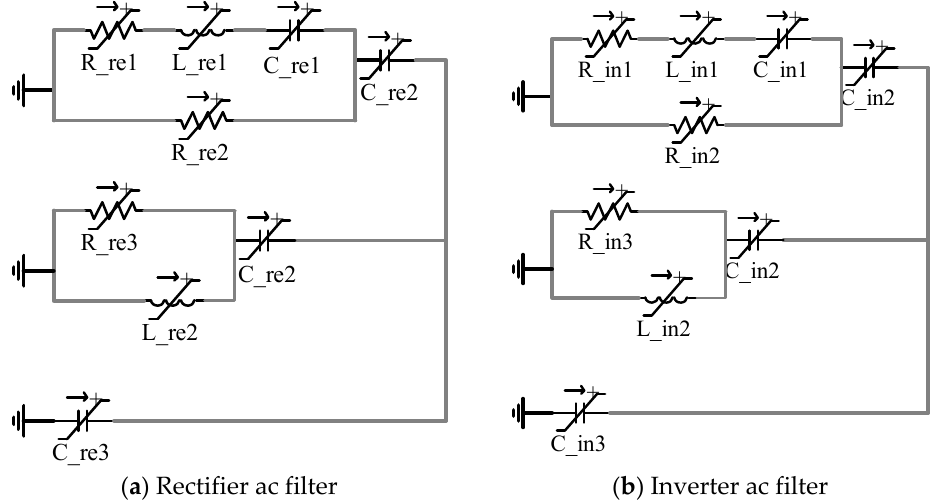
Figure 2. ( a ). AC filters installed at rectifier and ( b ) inverter side of the LCC-HVDC system.